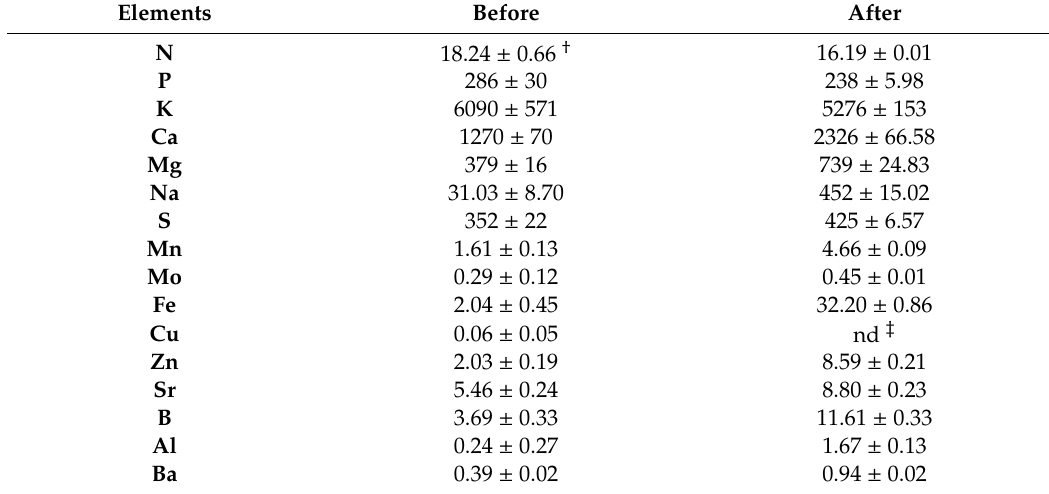
Content of macro- and microelements (mg L − 1 ) in alfalfa brown juice before and after